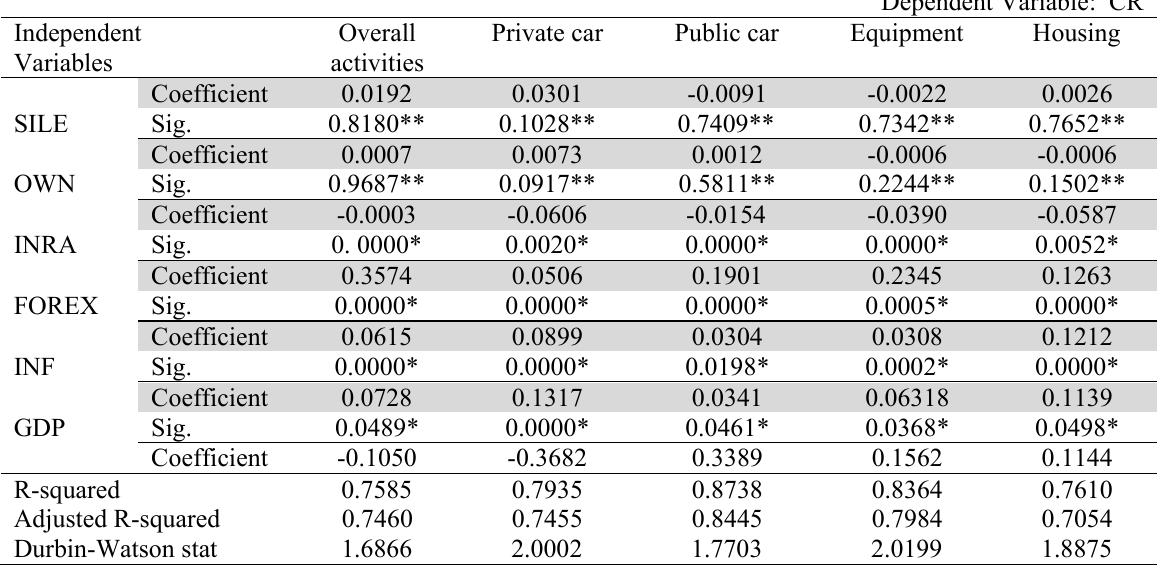
Regression results of OLS estimation